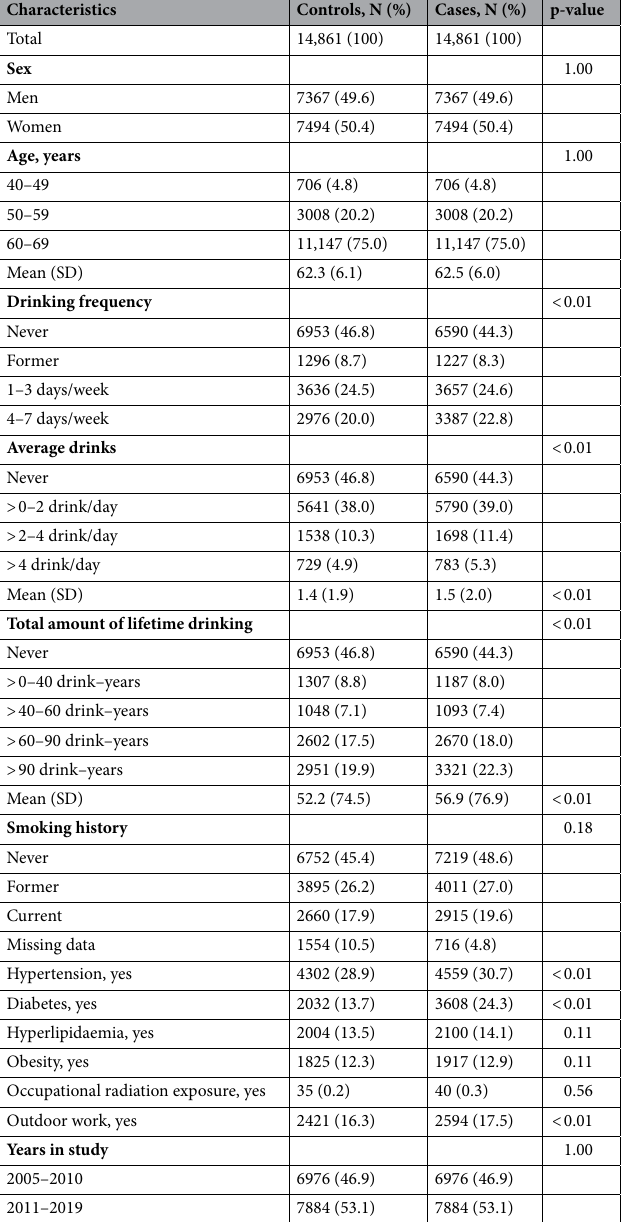
Table 1. Characteristics of cases and controls. Data are shown as mean (standard deviation) for continuous variables and number (percentages) for categorical variables. P values were for the t test for continuous variables and Chi-square test for categorical variables. SD standard